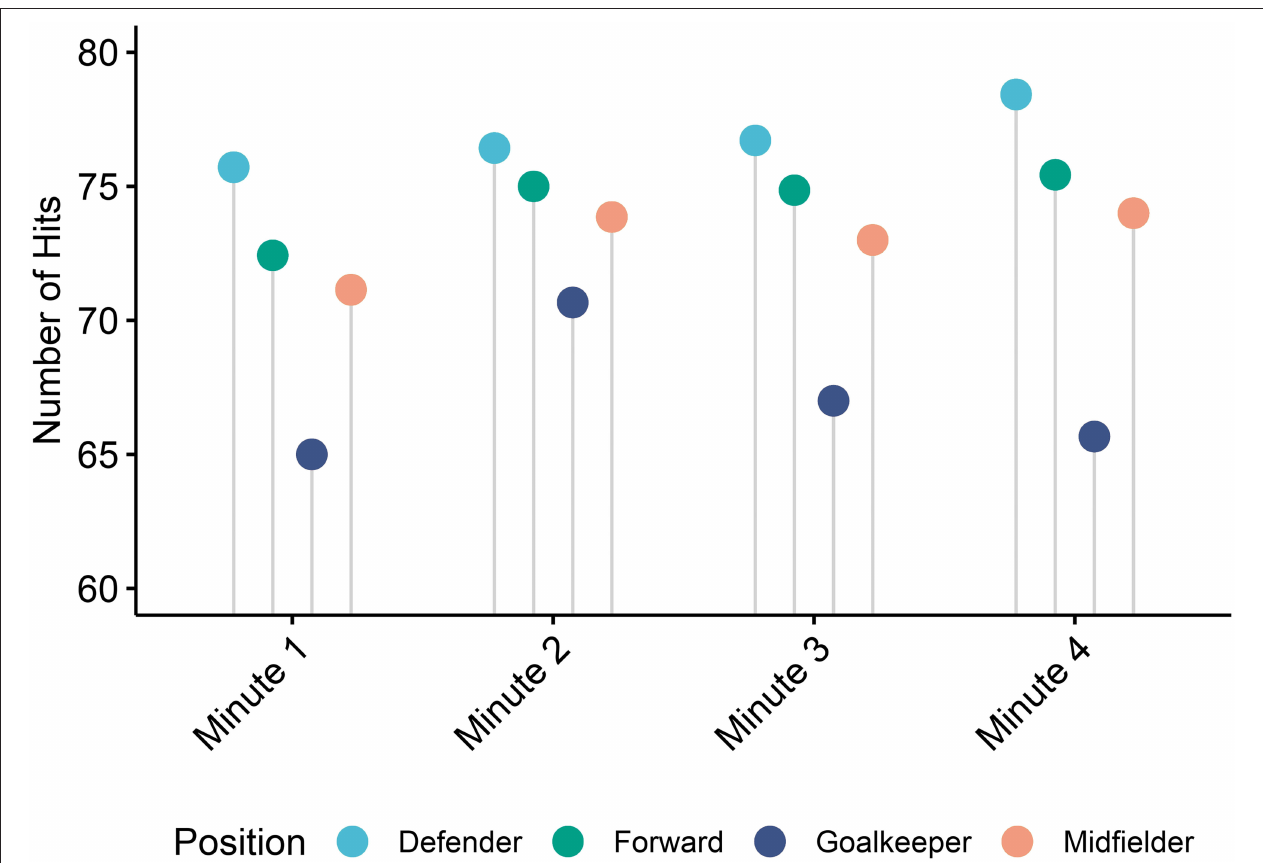
FIGURE 5 | Hits during each minute of the Endurance task. The figure demonstrates the mean number of hits recorded for each position during each of the 4min of the Endurance task.